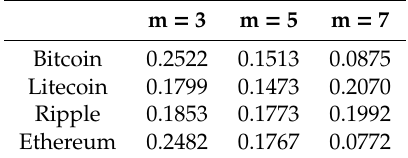
Table 7. Largest Lyapunov exponent results (tau =